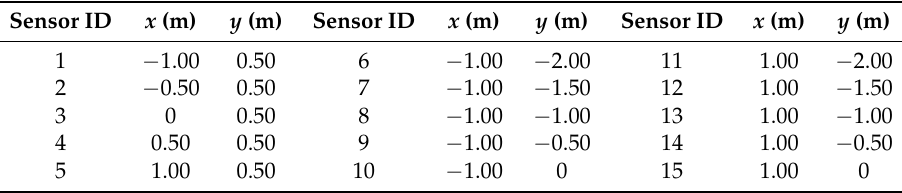
Table 1. Positions of the Microwave Sensors in the First Simulated Scenario. Aligned